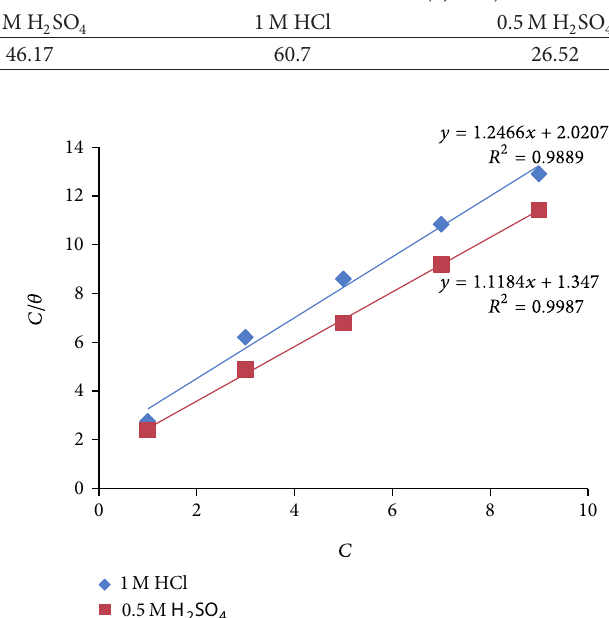
and for the corrosion of mild steel in 1M HCl and 0.5M H ∘ ∘ Δ𝑆𝑆 Δ𝐻𝐻